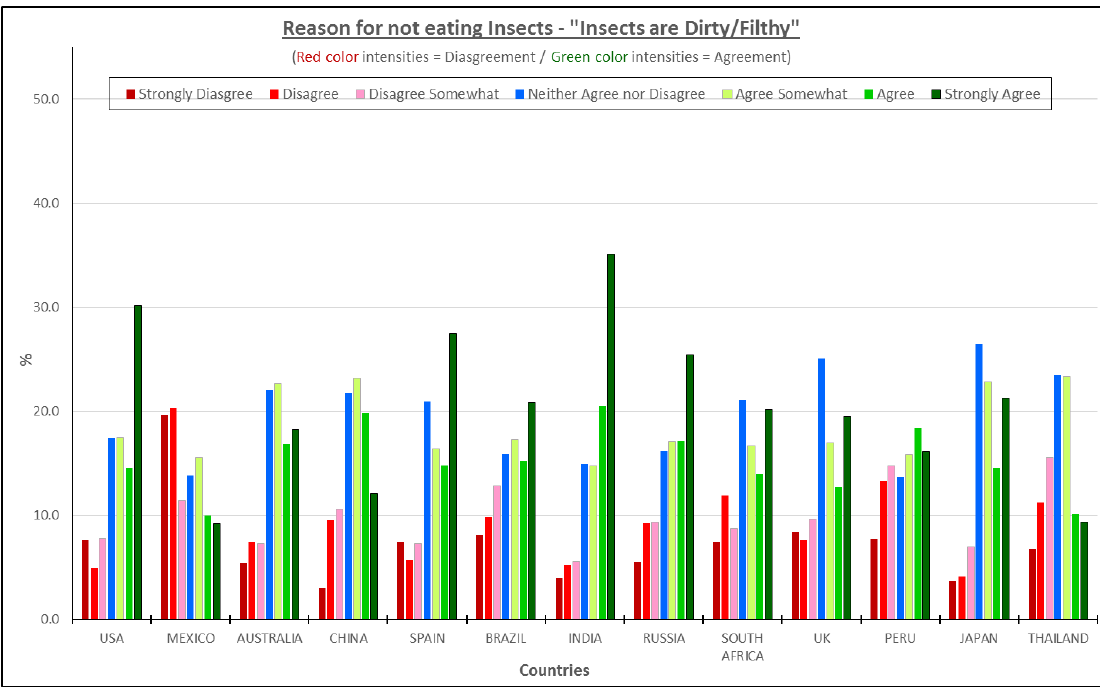
Figure 7. The reasons for not eating insect products—“Insects are dirty/filthy”.